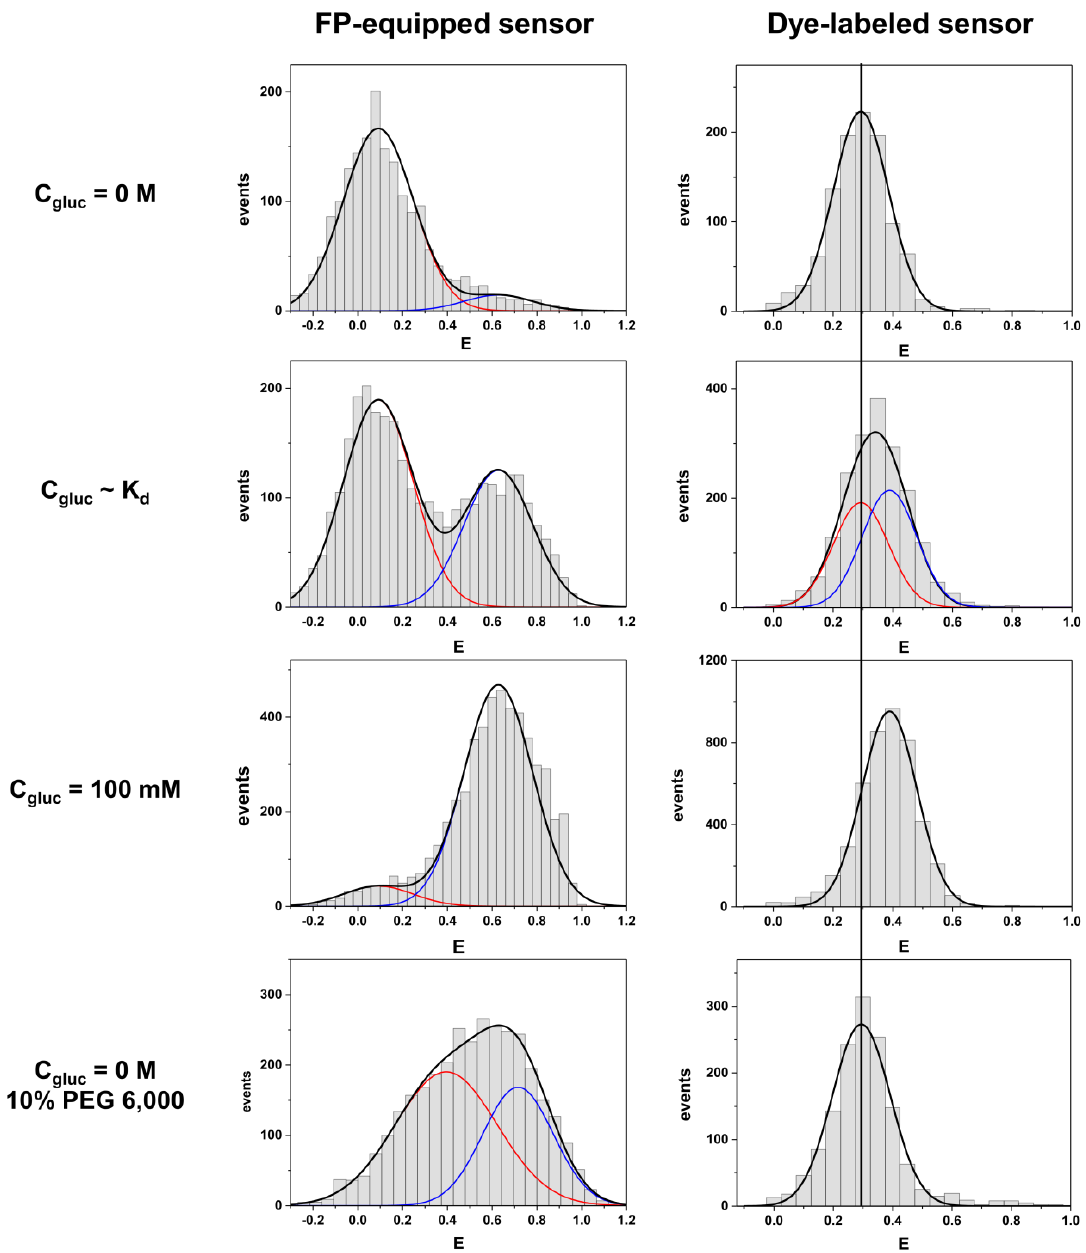
Figure 2. Comparison of smFRET histograms obtained from FP-equipped (left column) and dye-labeled (right column) species of MglB for four different conditions (from top to bottom): ligand-free state, ligand-bound state at the concentration near the K d (for values see Figure 3), fully ligand-bound state and ligand-free state in presence of 10% ( w / w ) PEG 6,000 as a crowding agent. Data shown for the FP-equipped sample were taken from [22]. For the sample labeled with fluorescent dyes a vertical line corresponding to the position of the ligand-free state, is drawn for reference.